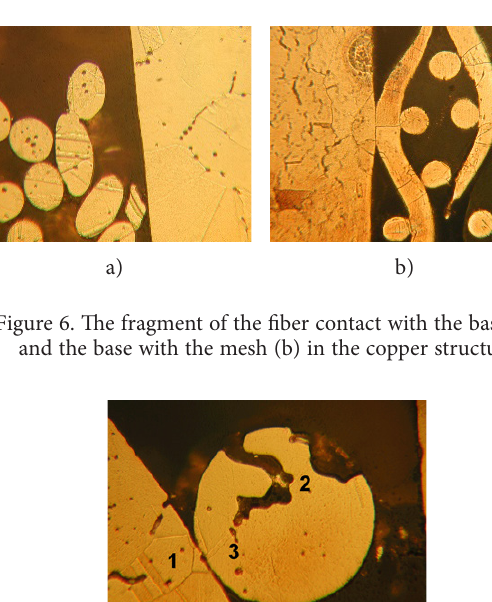
(Figure 9) for fibrous elements and mesh with the ground.